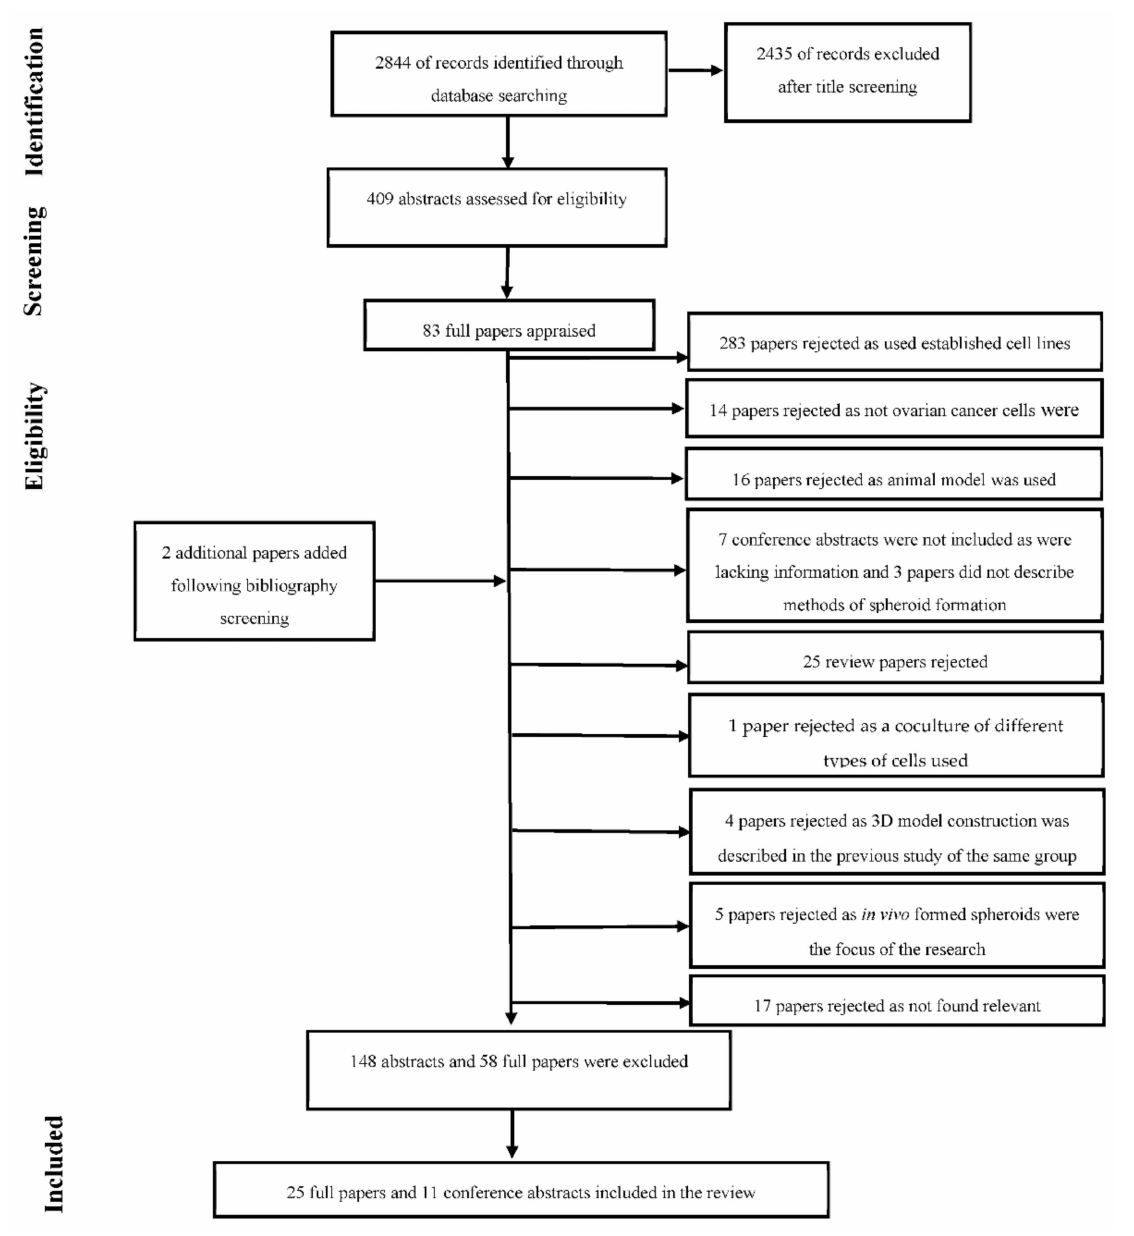
Figure A2. PRISMA flow